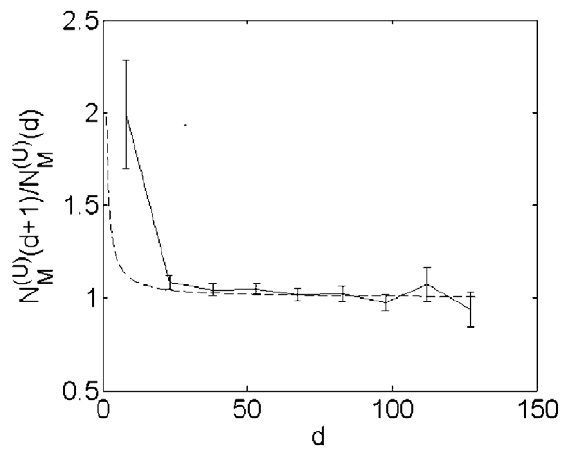
. Figure 3. N ( U ) d z 1 ð Þ N ( U ) d ð Þ vs. d for KEGG-based universal M M . d z 1 ð Þ N ( U ) d ð Þ (the ratio network with linearized pathways. N ( U ) M M of the number of metabolites at two consecutive layers) plotted as a function of d (the layer number) for KEGG-based universal network with linearized pathways. Solid line: measurement, dotted line: its expected profile, 1 z 1 = d , in a critical branching tree. The error bars reflect standard deviation in different spanning trees used to linearize the KEGG network.